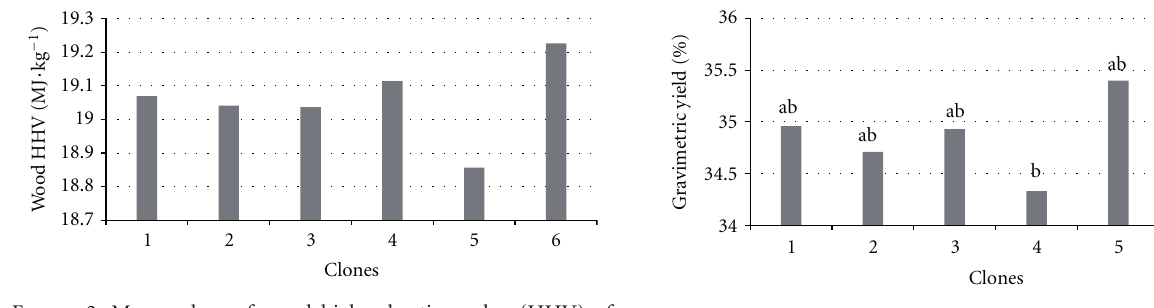
Figure 3: Mean values of charcoal gravimetric yield, in percentage. Standard deviation = 0.66; variation coe ffi cient = 1.3%. Means followed by same letter do not di ff er at 5% probability by Tukey